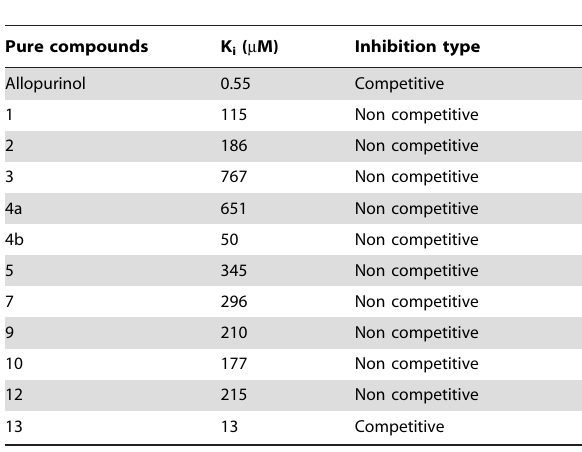
Table 2. Inhibition type and K i values of the pure